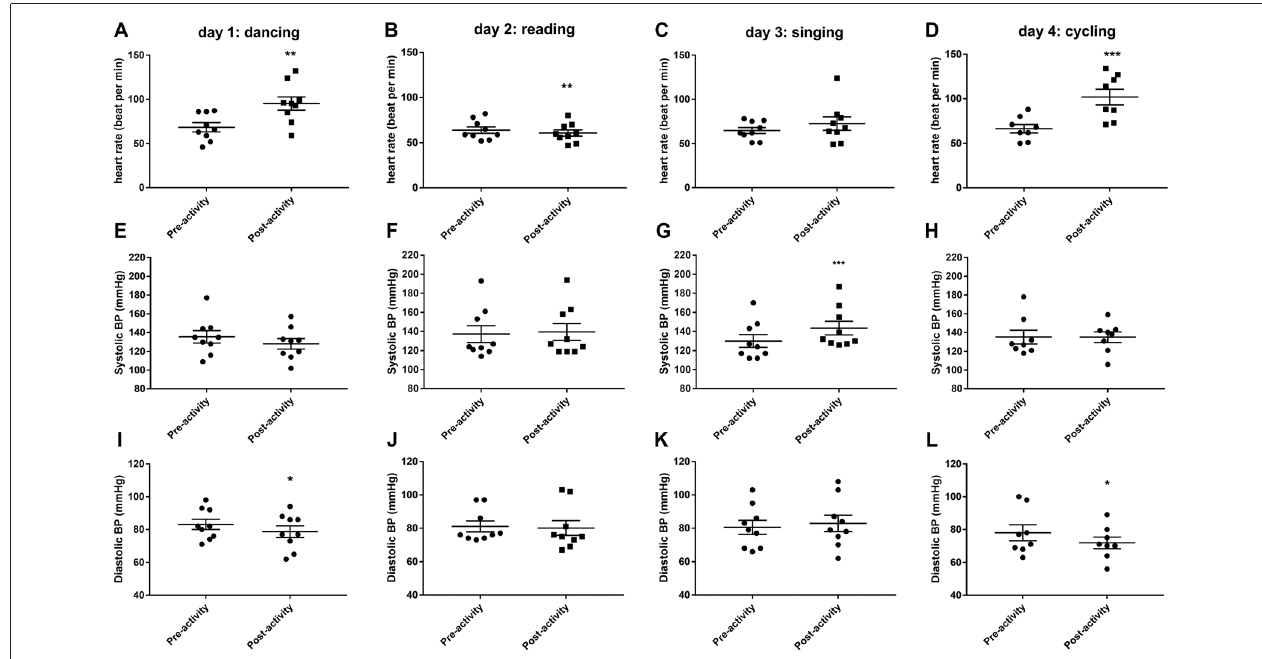
FIGURE 1 | Changes in cardiovascular parameters (heart rate, HR; A–D ), systolic blood pressure (E–H) and diastolic blood pressure (I–L) before and after 30 min activity (dancing, reading, singing or cycling) in nine healthy female volunteers. Data is presented as a scatter plot with mean ± SEM. Data sets were compared by paired Student’s t -test pre and post-activity ( ∗ P < 0.05, ∗∗ P < 0.01 and ∗∗∗ P < 0.001).